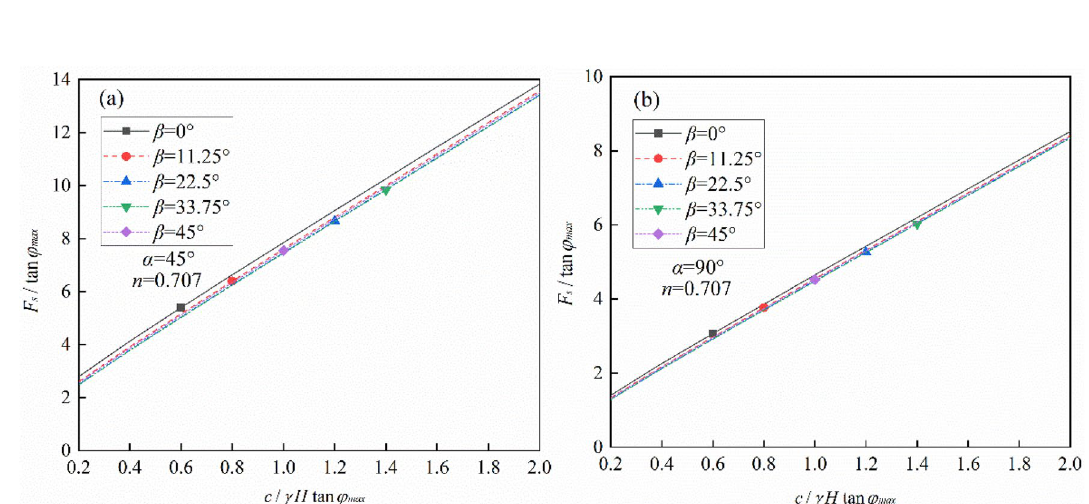
Figure 7. Stability chart for slopes considering strength anisotropy: ( a ) α = 45°, ( b ) α =